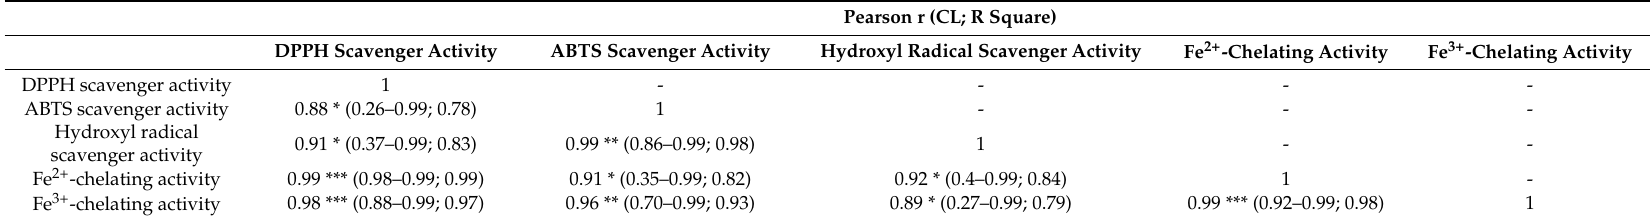
Table 6. Pearson correlation coefficient among antioxidant activity assays for DR2C extract Pearson r (CL; R